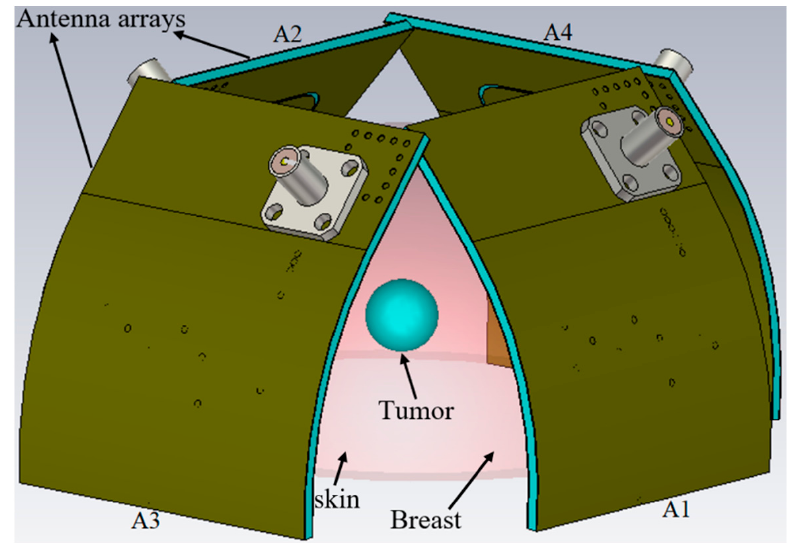
Figure 9. Simulated setup of the antenna array elements in on-body conditions, A1: antenna array 1; A2: antenna array 2; A3: antenna array 3; A4: antenna array 4